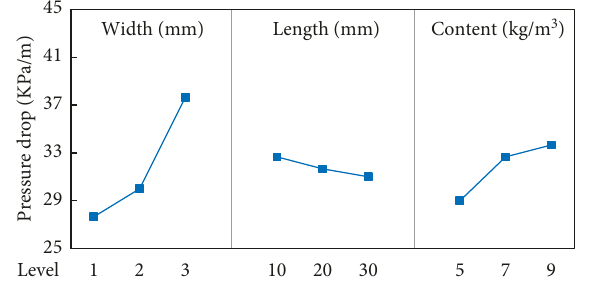
Figure 6: Main effect plot for pressure